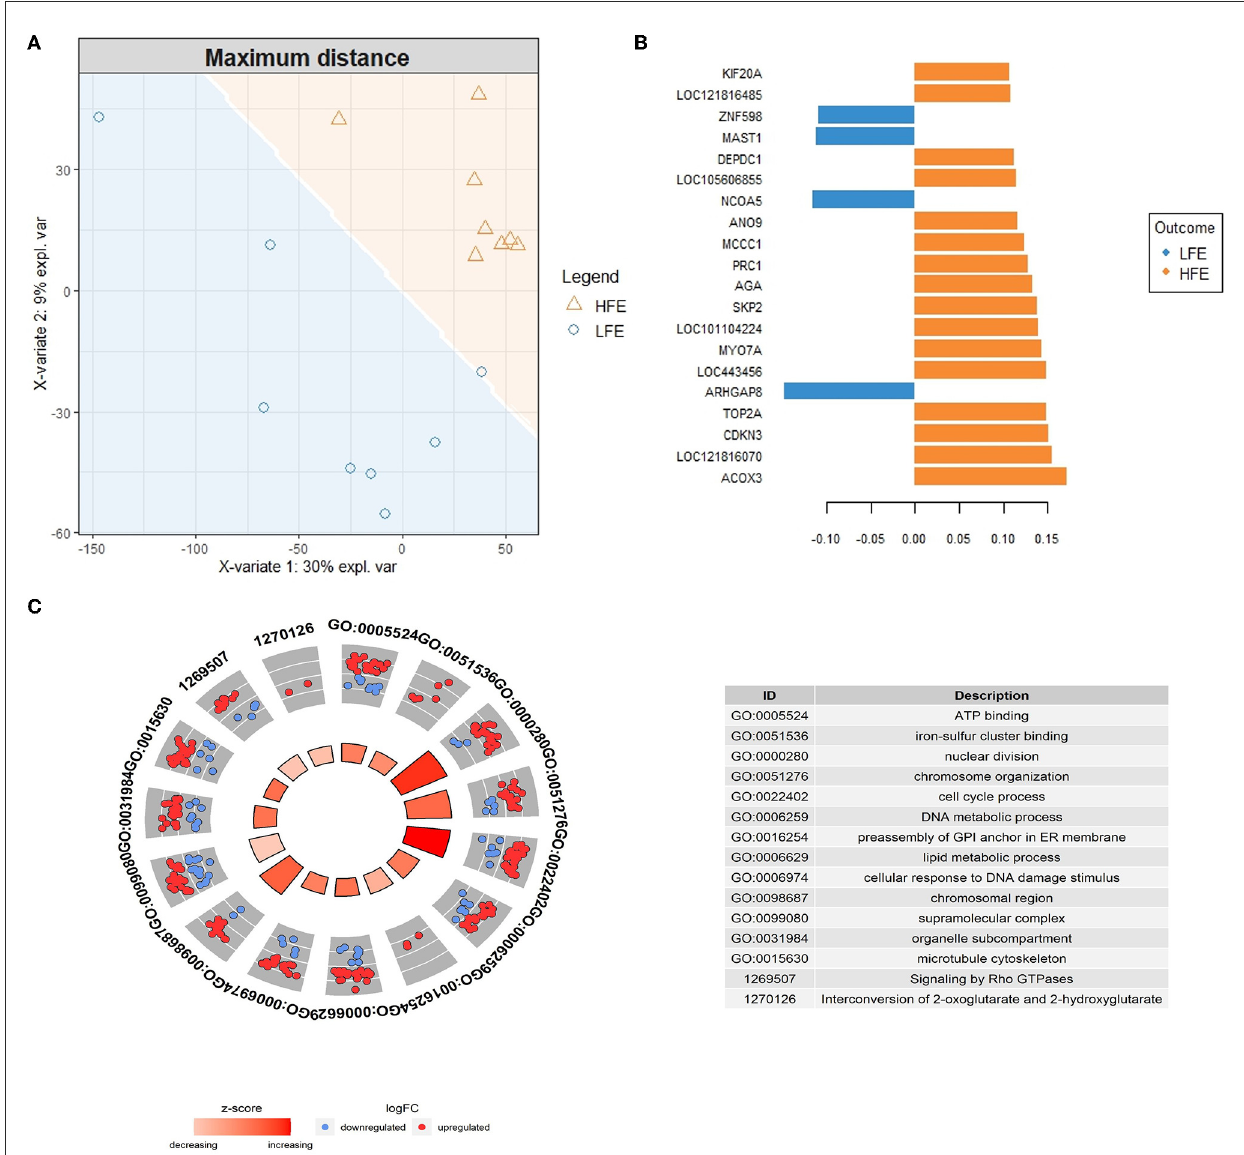
FIGURE2 Results from the sparse Partial Least Square-Discriminant analysis (sPLS-DA). (A) Sample prediction area plot from the sPLS-DA model applied on the RNA-Seq data set from high (H-FE; orange triangles) and low (L-FE; blue circles) samples using as the distance for prediction “maximum distance”. (B) Loading plot of the top 20 discriminating genes on the first component between high and low feed efficiency animals, colors indicate the group in which the mean expression is maximal for each gene (H-FE: orange and L-FE: blue). (C) GOCircle plot showing the significant GO terms and pathways enriched (FDR < 0.05) after a reduction of the terms with a gene overlap > 80% are represented. The outer circle shows a scatter plot for each term of the logFC of the genes clustered in the term. The blue circles are genes downregulated in H-FE, while the red circles are upregulated genes in H-FE sheep. The inner circle shows a bar plot representing the z -score for each term. The red color means that the GO term is upregulated for the H-FE group; the red color intensity is associated with the value of the z